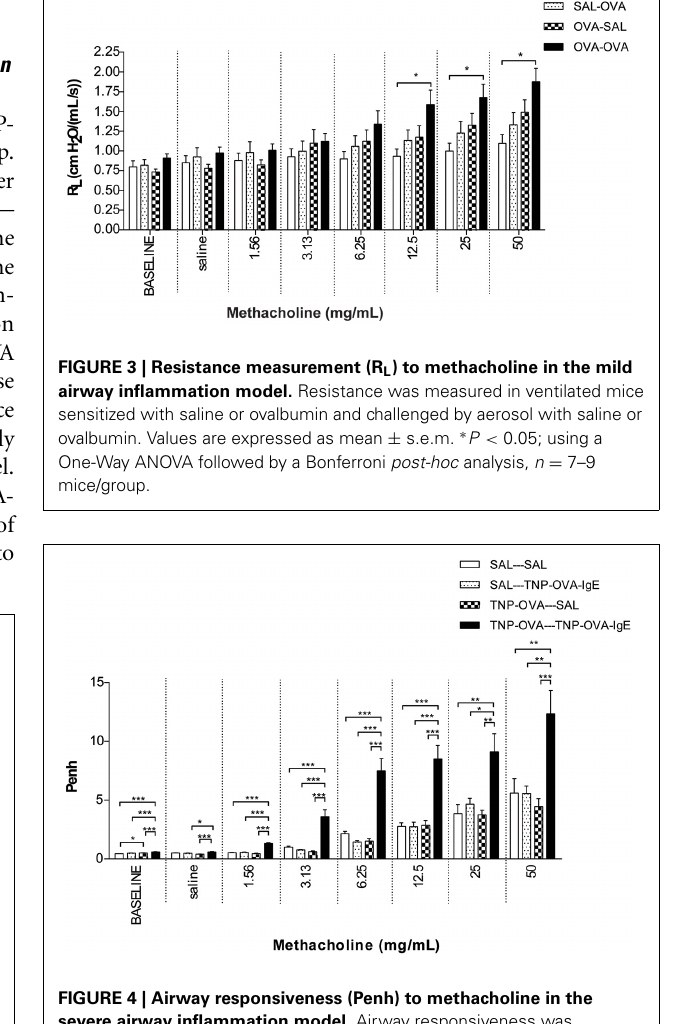
FIGURE 2 | Airway responsiveness (Penh) to methacholine in the mild airway inflammation model. Airway responsiveness was measured in mice sensitized with saline or ovalbumin and challenged by aerosol with saline or ovalbumin. Values are expressed as mean ± s.e.m. ∗ P < 0 . 05, ∗∗ P < 0 . 01, ∗∗∗ P < 0 . 001; using a One-Way ANOVA followed by a Bonferroni post-hoc analysis, n = 5–9 mice/group.